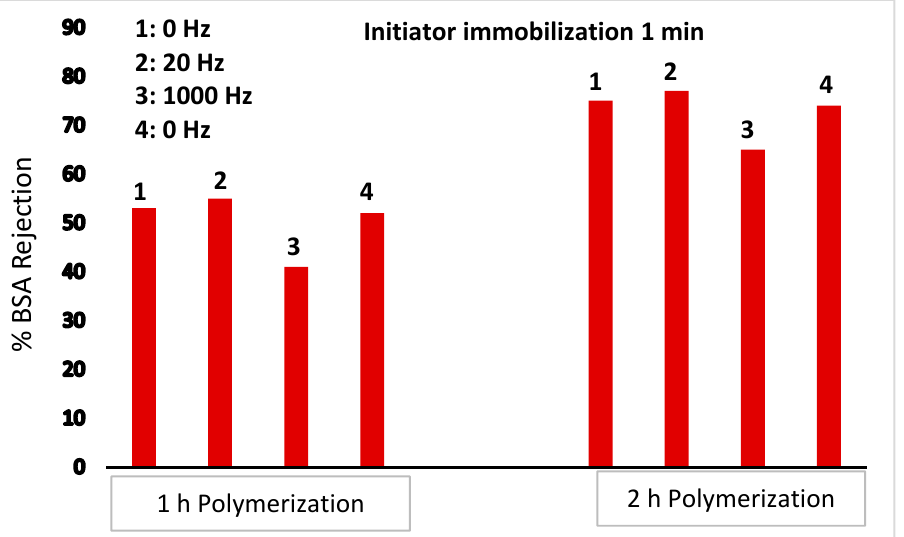
Figure 6. Variation of BSA rejection for inner membrane pore surface modification. Results are provided in the absence and presence of a 20 and 1000 Hz oscillating magnetic field.